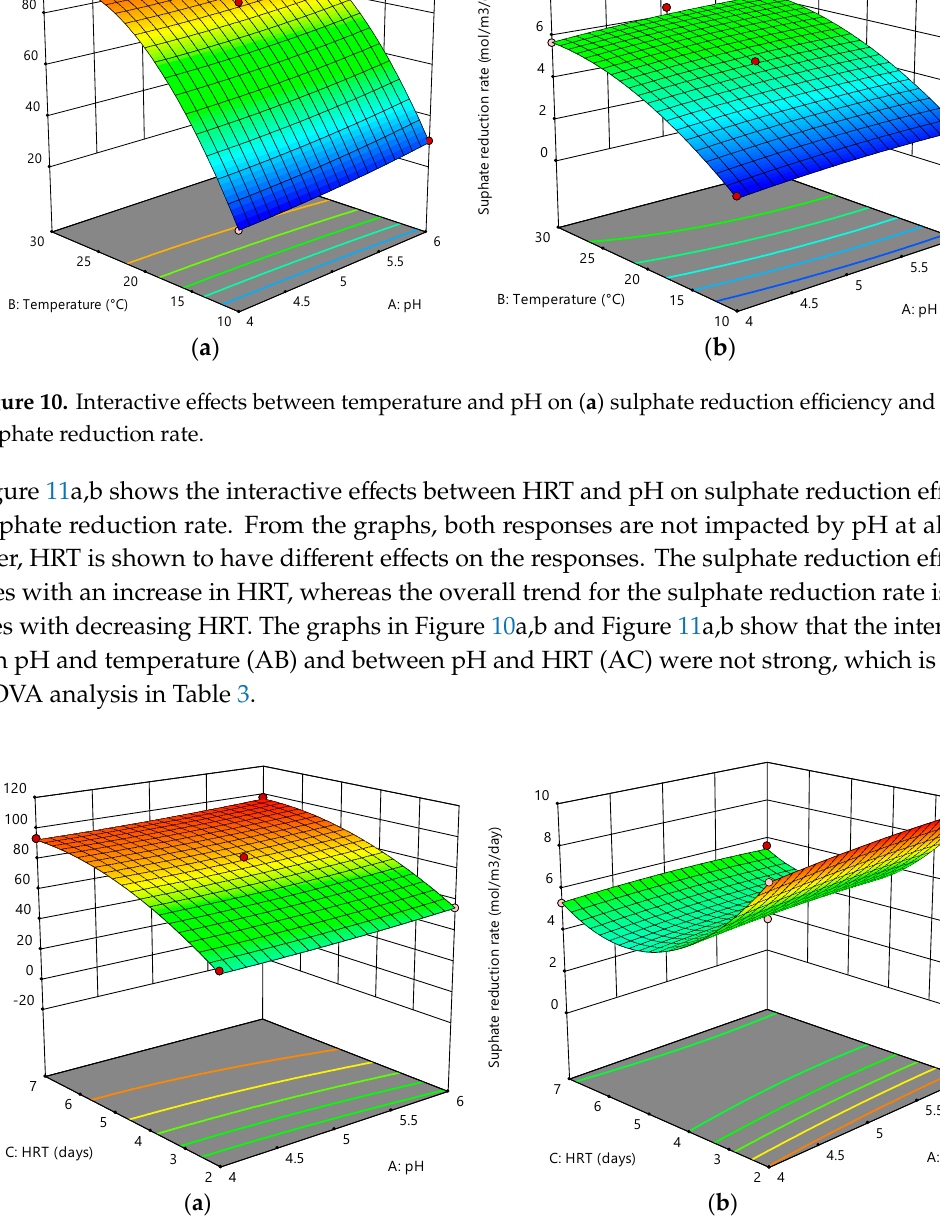
Figure 11. Interactive effects between HRT and pH on ( a ) sulphate reduction efficiency and ( b ) sulphate reduction rate.